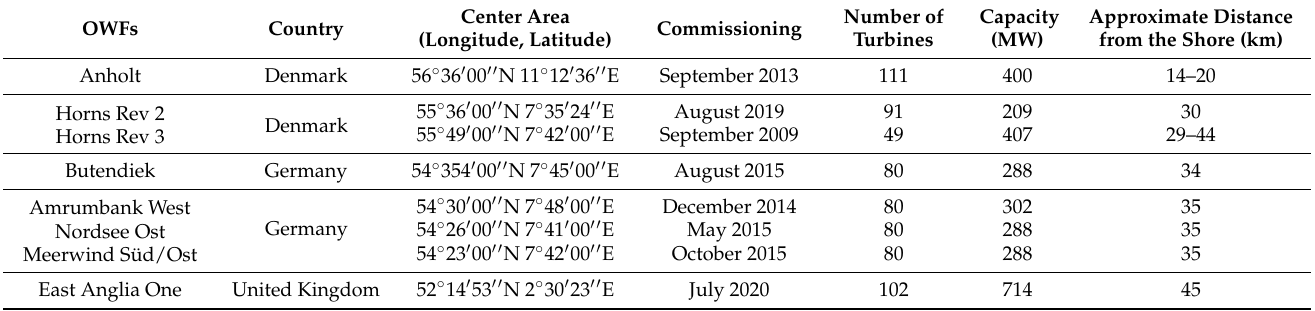
Figure 1. Positions of the selected OWFs in the North Sea and Kattegat. The Horns Rev cluster refers to the wind farms Horns Rev 2 and 3; the Global Tech cluster refers to Global Tech 1, Albatros, and Hohe See; and the Nordsee cluster refers to Amrumbank West, Nordsee Ost, and Meerwind Süd/Ost. Table 1. OWFs selected for this study and their characteristics. This information is taken from the global offshore wind farm database (4coffshore.com accessed on 31 January 2022), Wikipedia, and official websites of the companies owning these